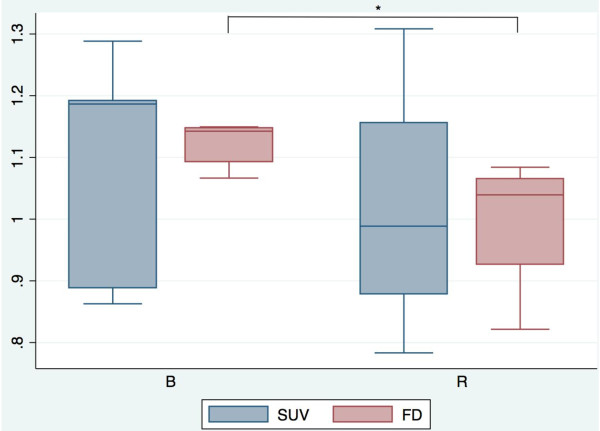
Box-Whiskers plots of the median SUV 55 to 60 min and FD for both tracers. *P values < 0.05. B, 68Ga-BZH3; R, 68Ga-RGD4.